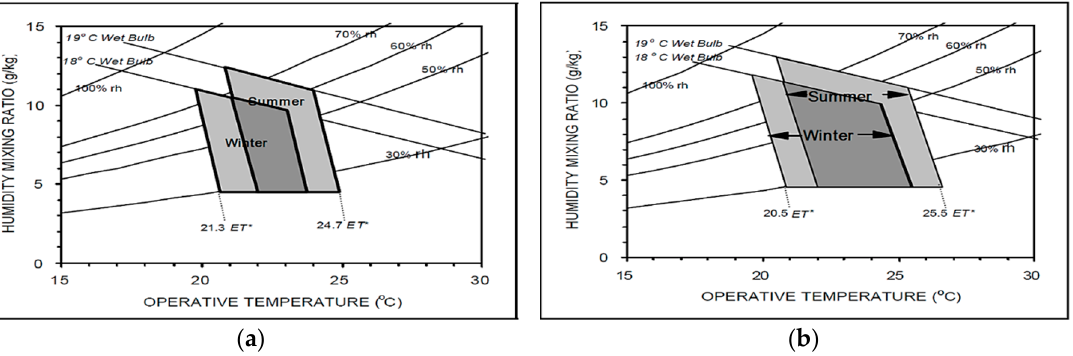
Figure 2. Seasonal comfort zone in the psychrometric chart. ( a ) 90% acceptability level; ( b ) 80% acceptability level.